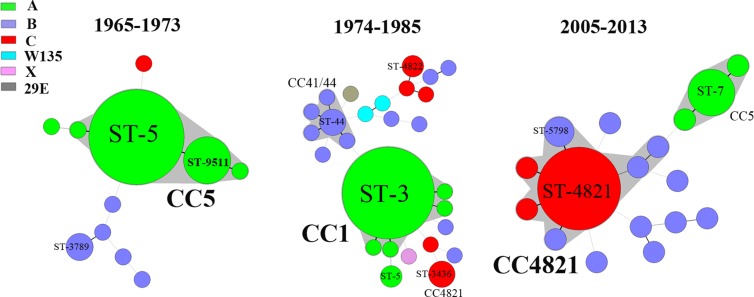
Minimum spanning tree analysis of multi-locus sequence types of N. meningitidis from patients.Isolates were obtained from patients during the periods 1965–1973, 1974–1985, and 2005–2013. STs are displayed as circles. The size of each circle indicates the number of isolates of this particular type. Serogroup is distinguished by different colors. The shaded halo surrounding the STs encompasses related STs that belong to the same CC. Heavy solid lines represent SLVs, and light solid lines represent DLVs.